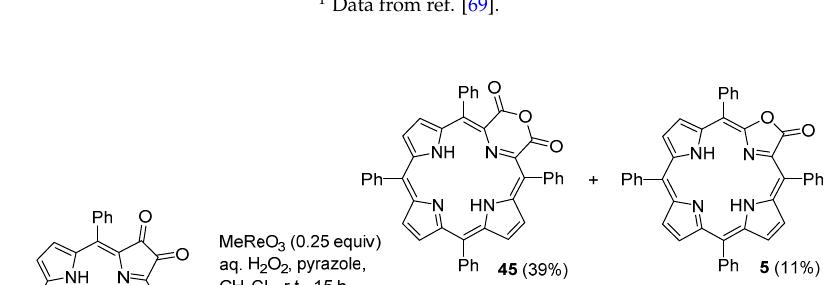
Molecules 2016 , 21 , 320 11 of